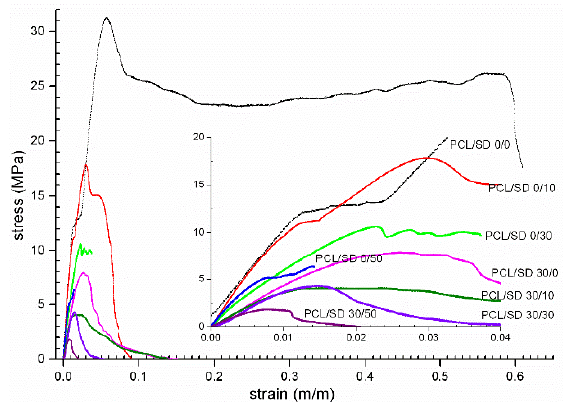
Figure 2. Sample stress–strain curves of rPET-based composites filled with 10 vol.%, 30 vol.% and 50 vol.% of SD, with and without the addition of PCL (30 vol.%), noted as PCL/SD PCL%/SD% . Inset figure presents a magnification of the small strain region.